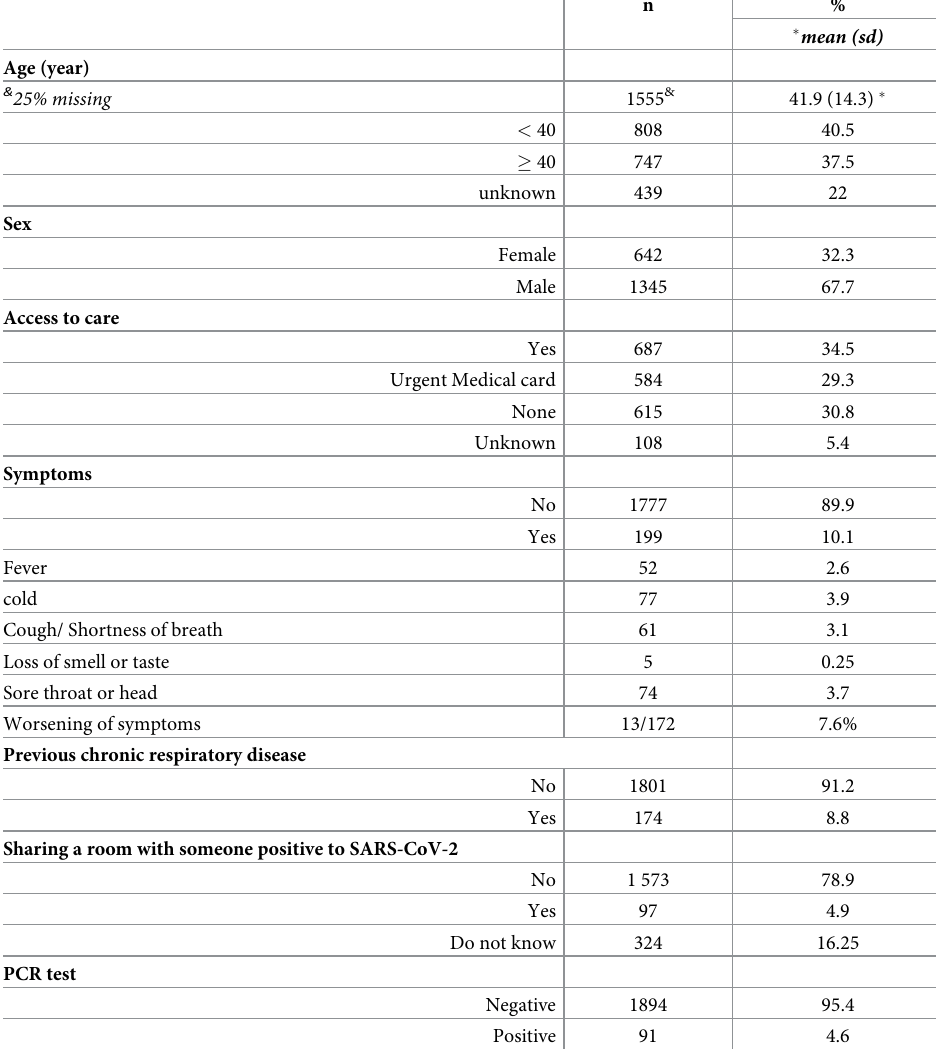
Table 1. Characteristics of study participants (N =